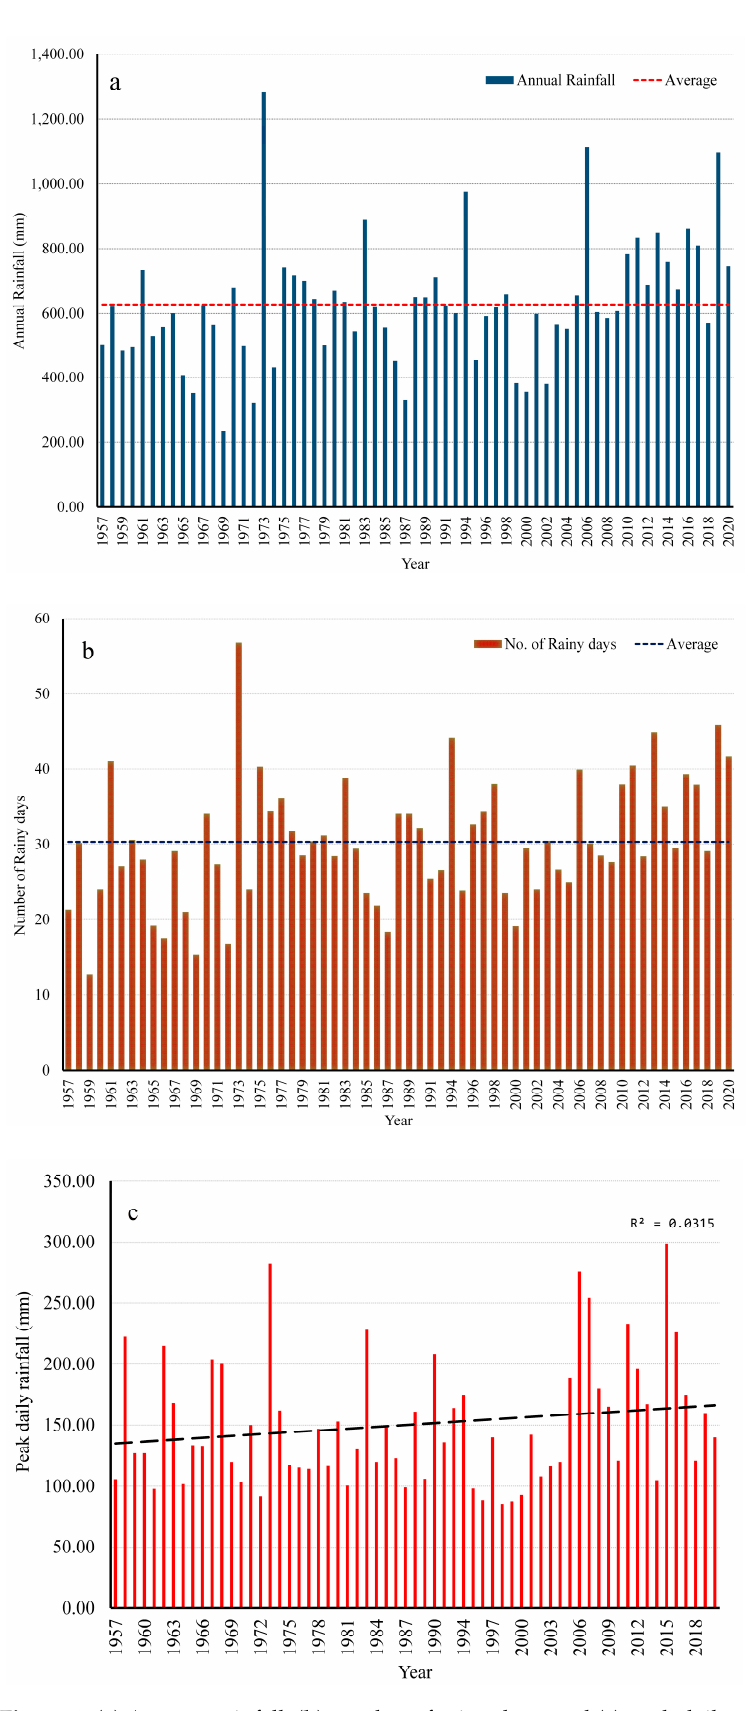
Figure 4. ( a ) Average rainfall, ( b ) number of rainy days, and ( c ) peak daily rainfall of the study area.